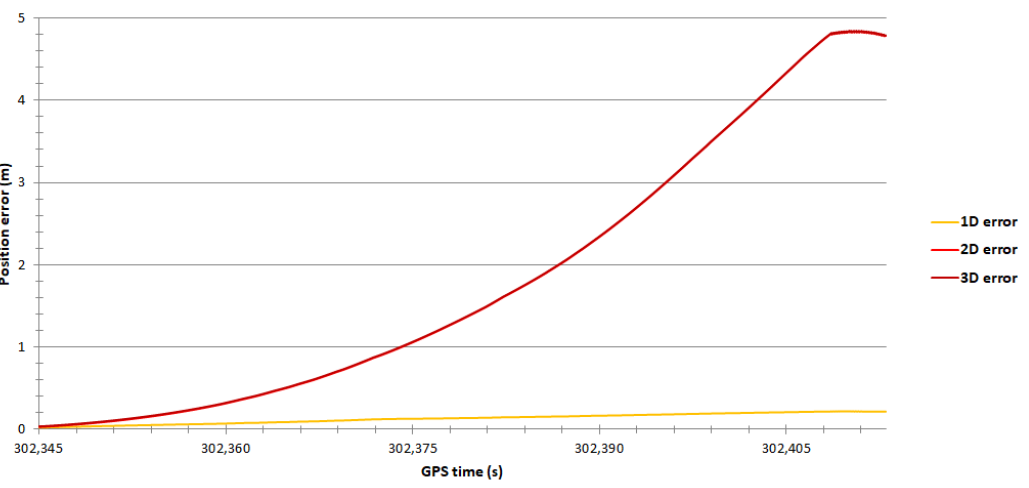
Figure 12. Variability in position errors recorded by the GNSS/INS system in the RTK mode in section no. 3.